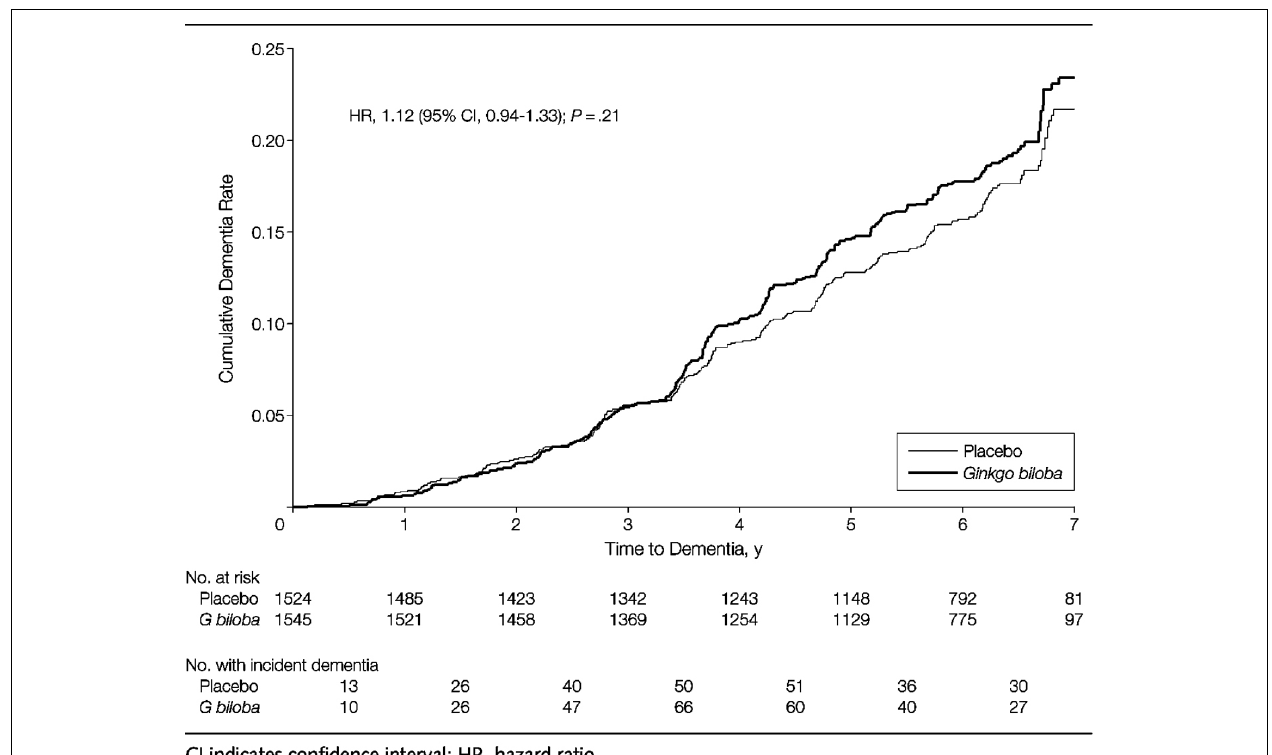
FIGURE 2 |The effect of Ginkgo biloba on Cognitive Function in the GEMTrial (taken from DeKosky etal., 2008).